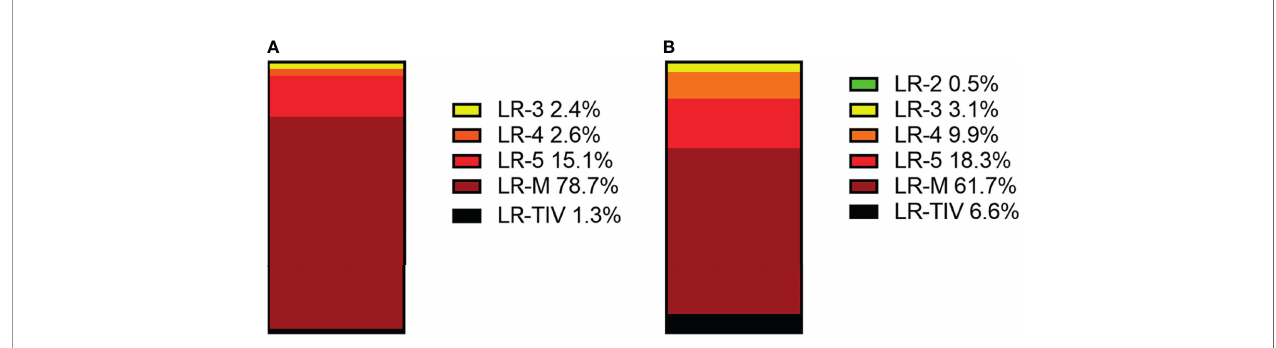
FIGURE 4 | Distributions of non-HCC malignancies in each CEUS category (A) and CT/MRI category